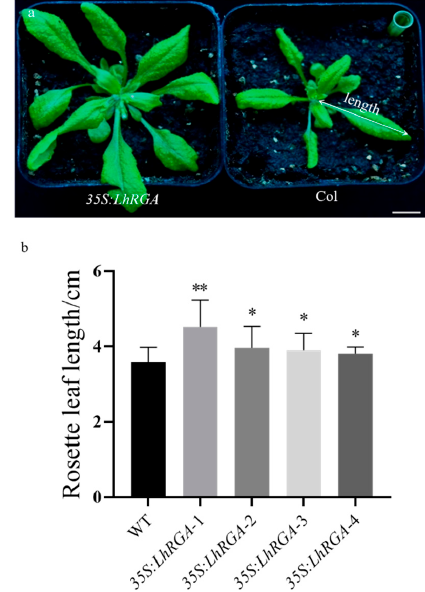
Figure 7. Morphological phenotypes of Arabidopsis overexpressing LhRGA . ( a ) Phenotypes of 28-day-old wild-type and transgenic plants. Scale bar = 1 cm. ( b ) Measurement of rosette leaf length in the wild-type and transgenic lines ( a ). Error bars: ± SD. * p < 0.05; ** p < 0.01.